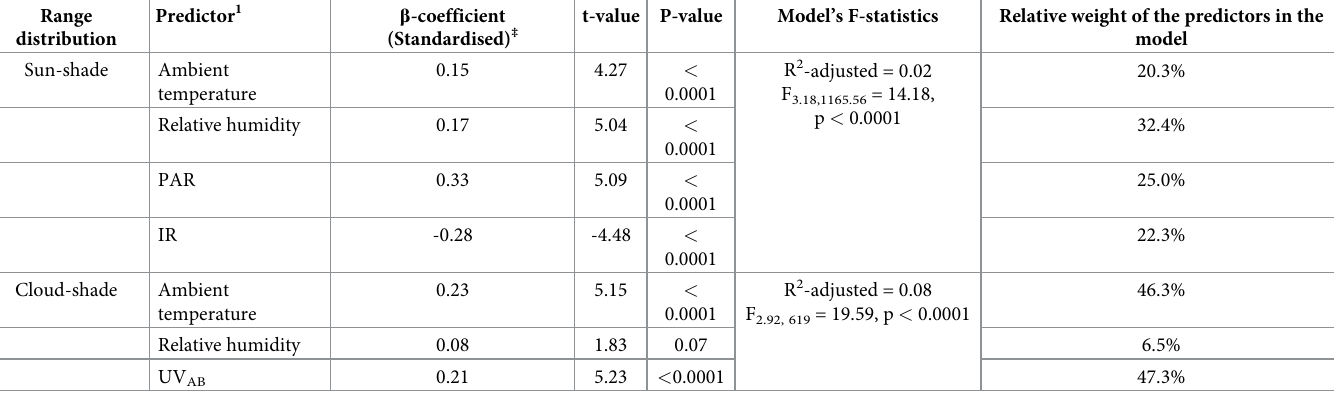
Table 3. Multiple ridge regression analyses (ridge parameter, k = 0.02) on the number of hens in the ‘sun-shade’ and ‘cloud-shade’ across the day in TAS for all observation months. Only variables that significantly contributed to the most parsimonious model are presented. Range distribution